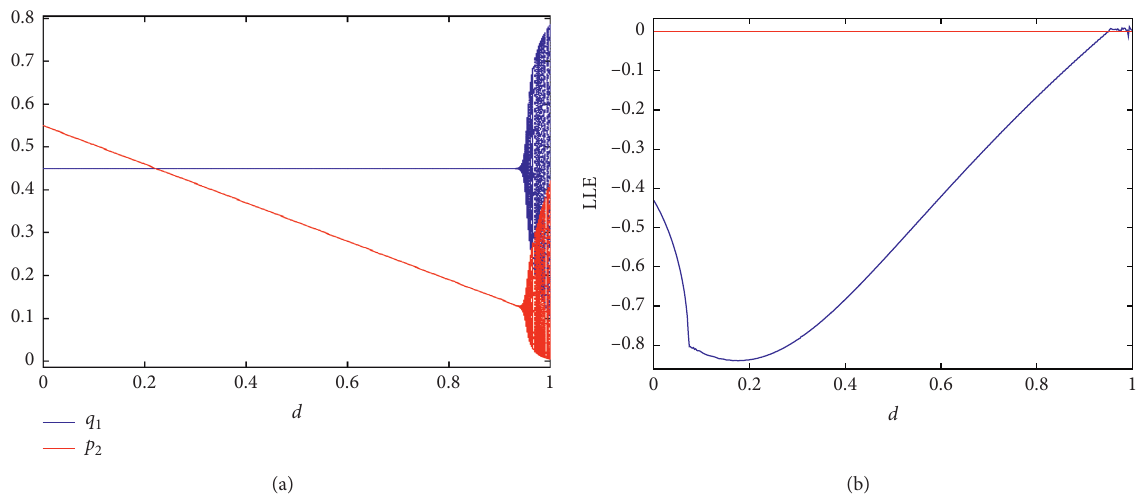
Figure 8: (a) Bifurcation diagram and (b) LLE with respect to d when α � β � 1 . 5.